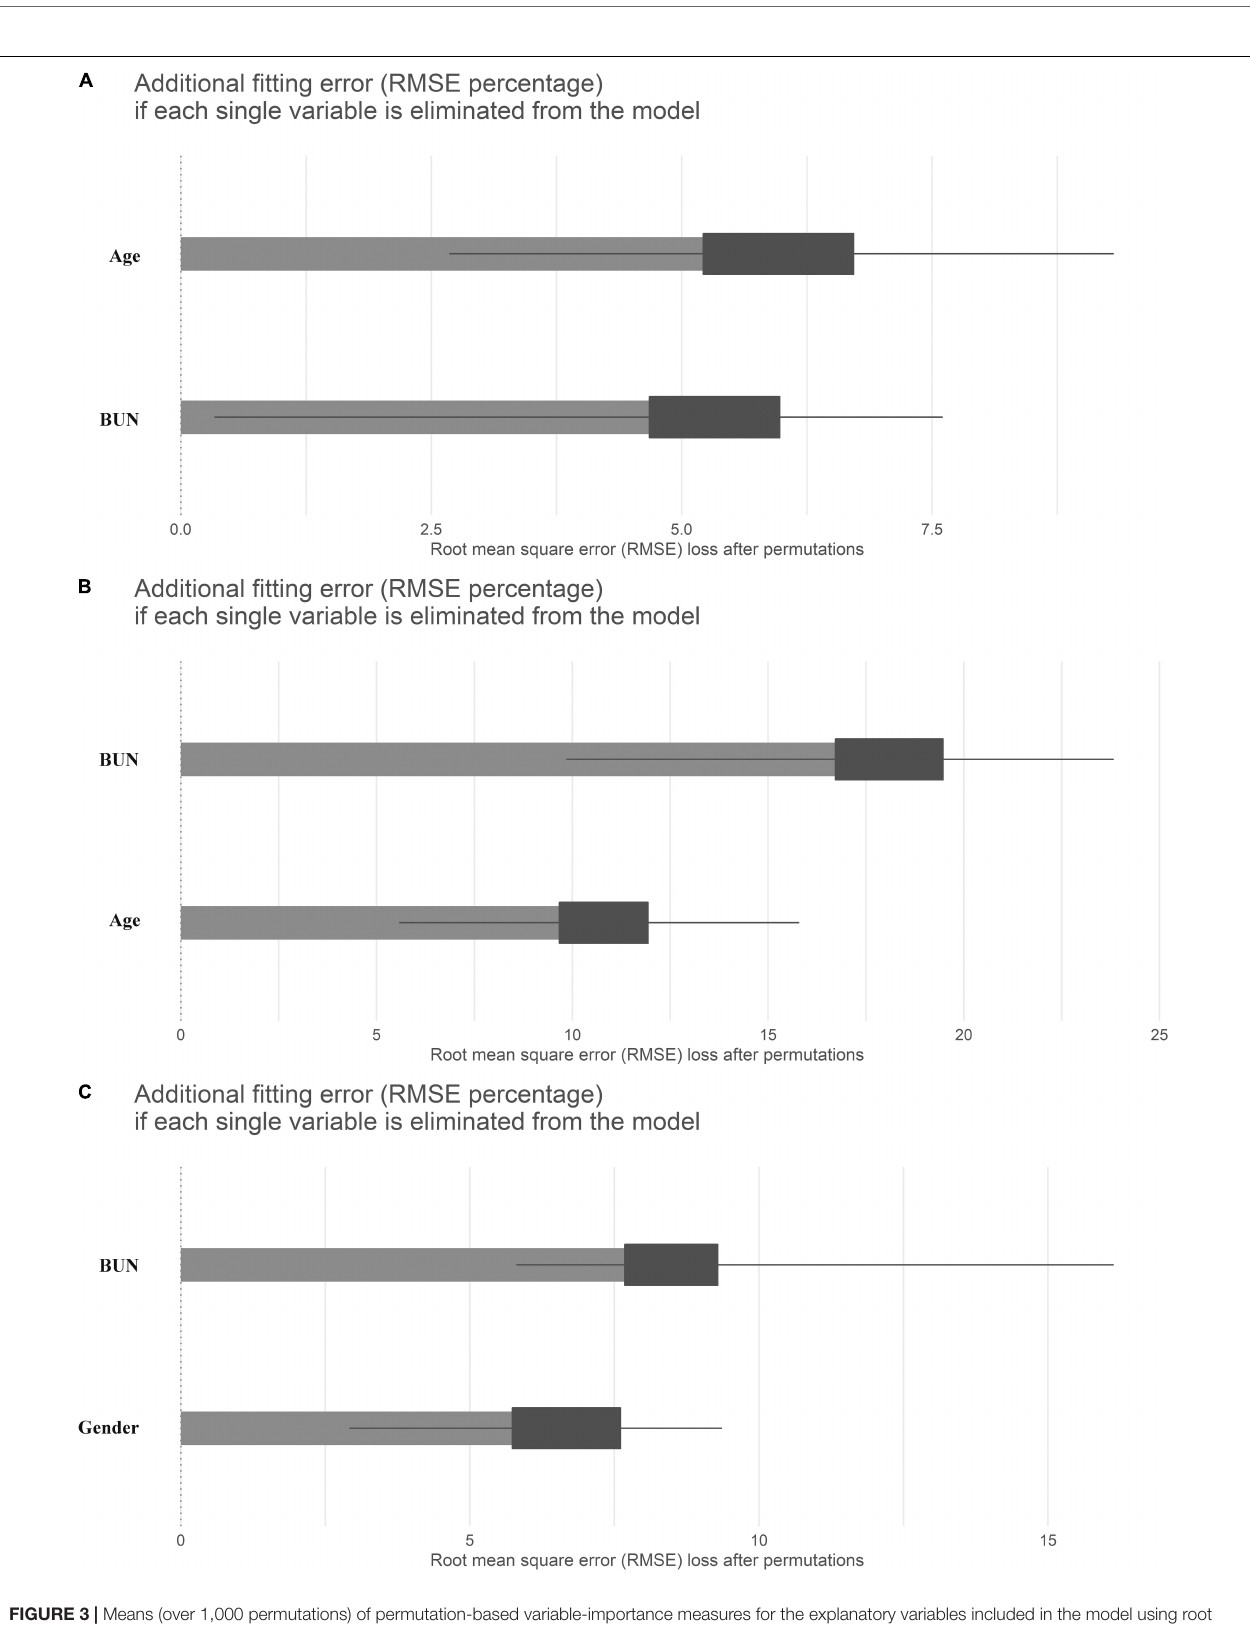
FIGURE 3 | Means (over 1,000 permutations) of permutation-based variable-importance measures for the explanatory variables included in the model using root mean square error (RMSE) as the loss function. (A) Comparison between full age spectrum (FAS) and Chronic Kidney Disease Epidemiology Collaboration (CKD-EPI) equations, (B) between Berlin initiative study 1 (BIS1) and CKD-EPI, and (C) between FAS and BIS1.